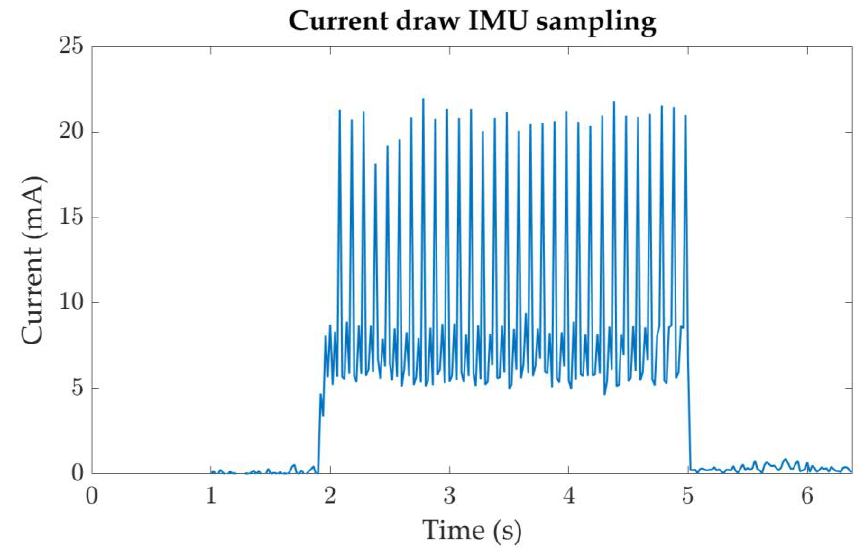
Figure 7. Current consumption while sampling IMU at 12.5 Hz and activating GNSS receiver.